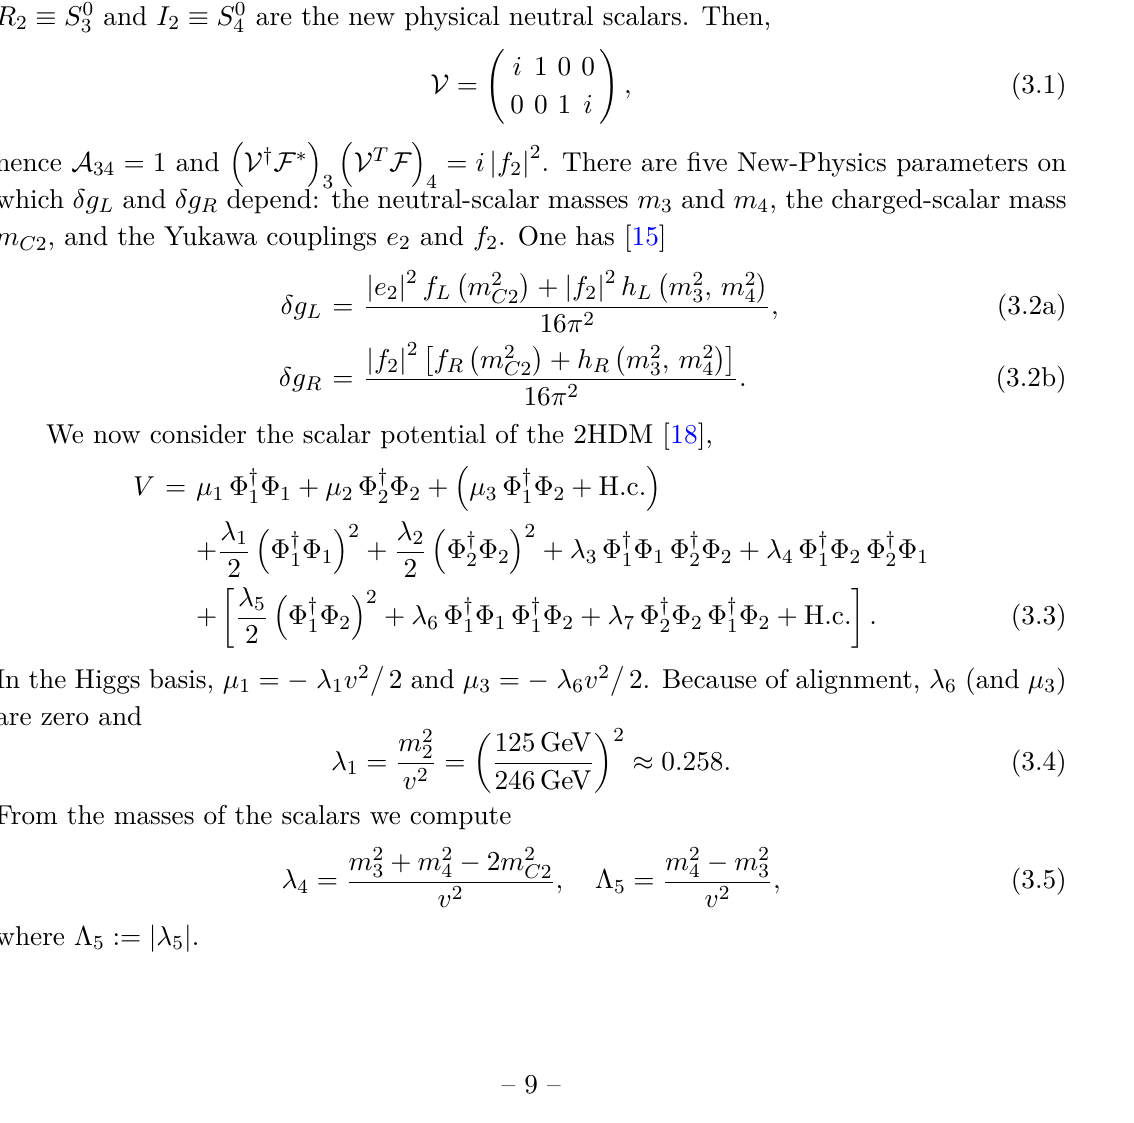
(cid:0) (cid:1) h R m 2 , m 2 j j 0